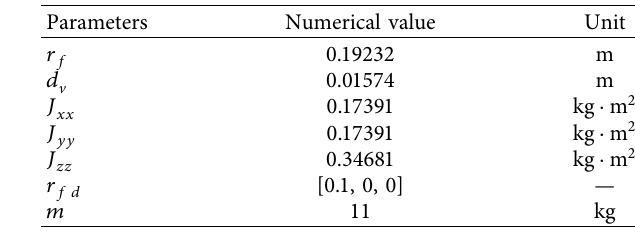
Table 1: Model’s main parameter